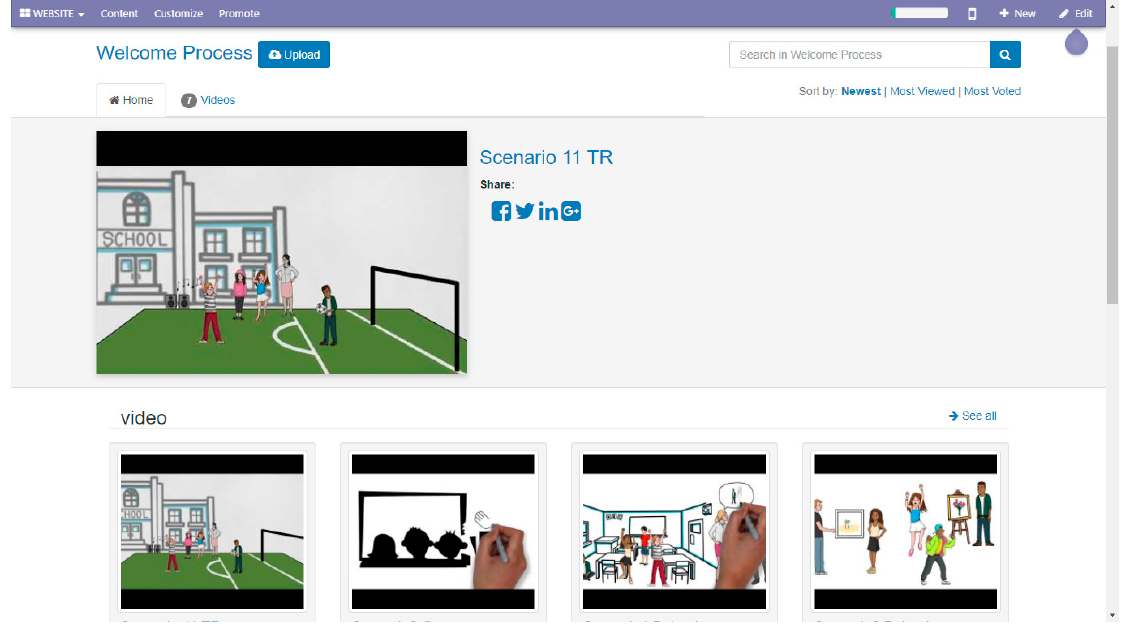
Figure 7. Screenshot of welcome process supporting video